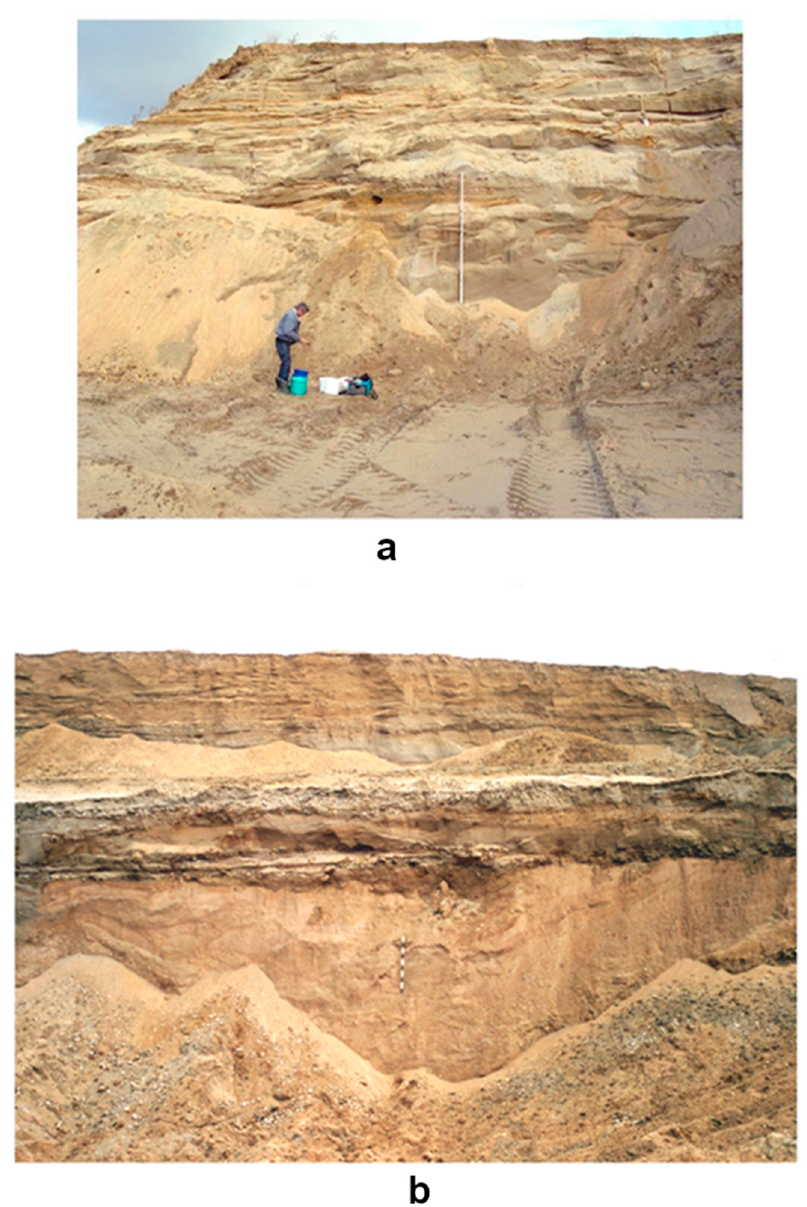
Figure 20. The Mosbach Sands (Wiesbaden). ( a ) The upper part, Middle Pleistocene; ( b ) the lower part, Lower Pleistocene. (Photos: LfD Hessen, T. Keller.).